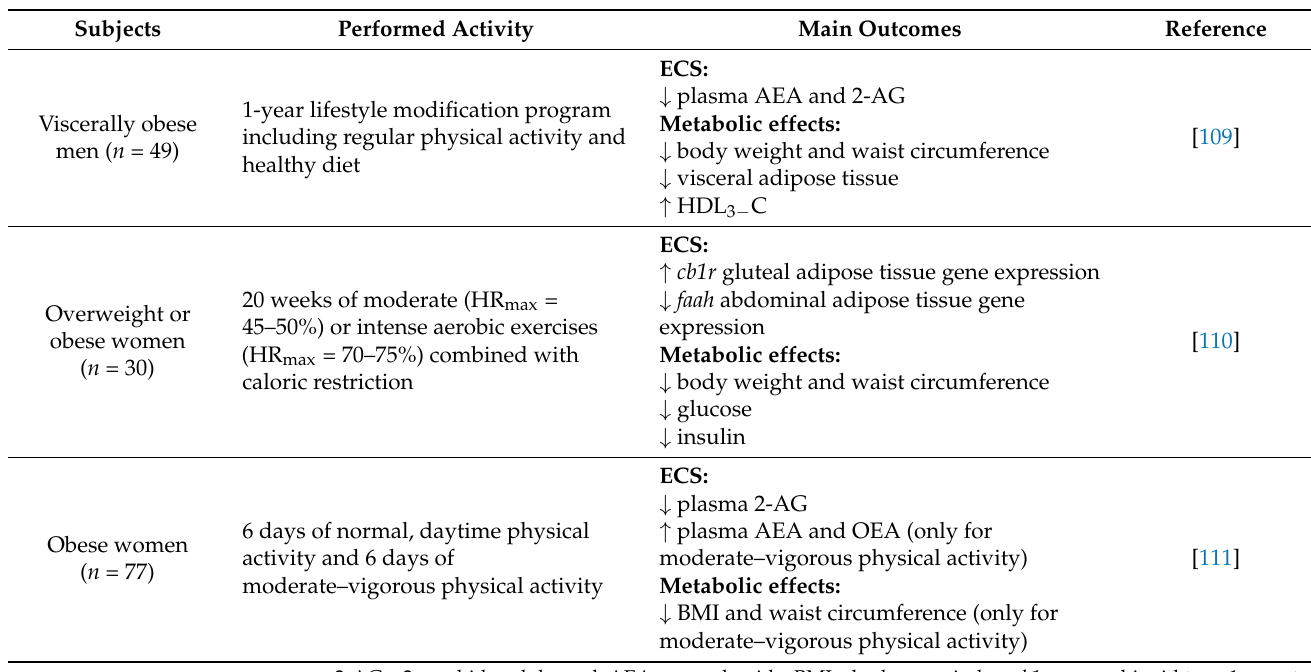
Table 1. A summary of the clinical studies showing the correlation between physical activity, alter- ations in the endocannabinoid system, and subsequent beneficial therapeutic effects in metabolic